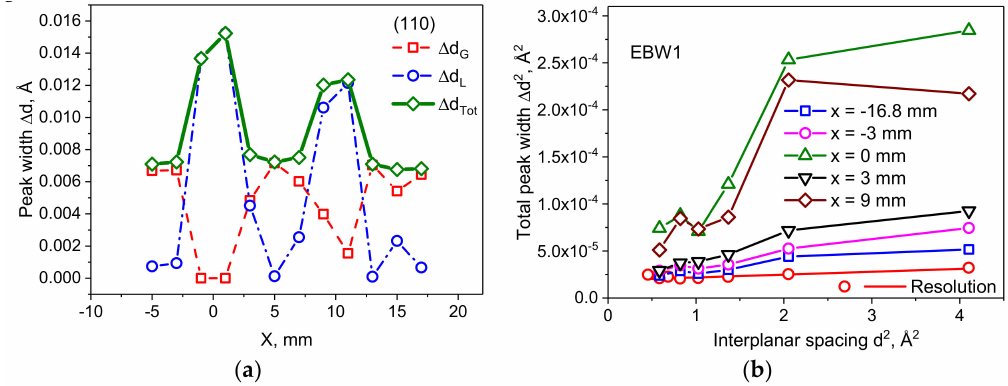
Figure 5. ( a ) The di ff raction peak (110) width for EBW2 specimen vs. scan coordinate X. The contributions of Gaussian ( ∆ d G ) and Lorentzian ( ∆ d L ) components to the total peak width ( ∆ d Tot ) are shown. ( b ) The dependence of total peak width ∆ d 2 vs. d 2 for spectra measured at di ff erent scan points on the specimen. The e ff ect of dislocation contrast factor variation is especially pronounced for the points corresponding to the weld seams centers at X = 0 and X = 9 mm. For comparison, the dependence measured with standard material and corresponding to the instrument resolution function is shown.